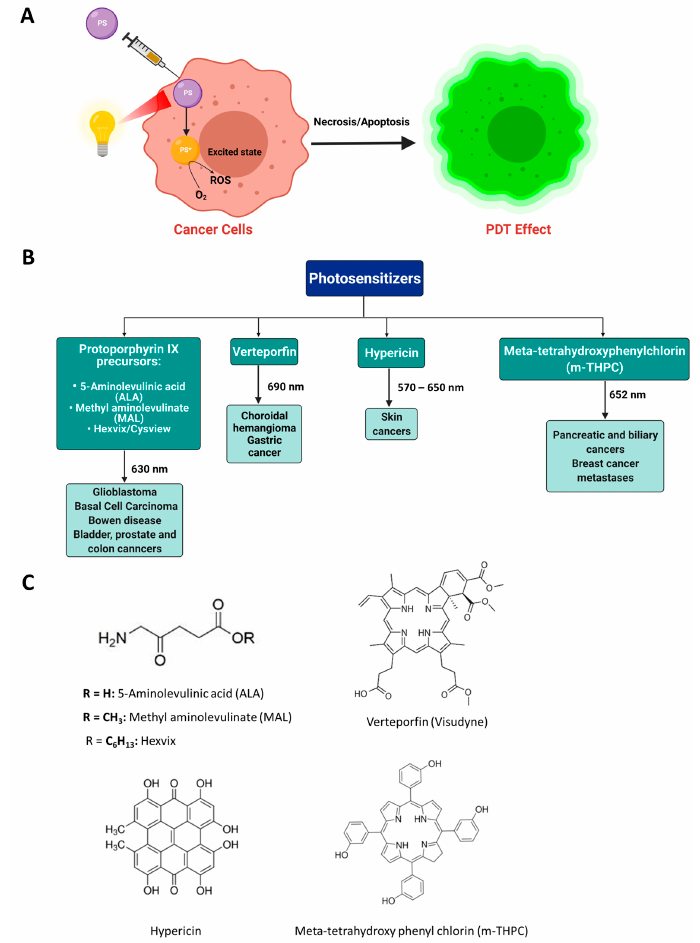
Figure 2. ( A ) General principle of photodynamic therapy; ( B ) FDA and/or EU-approved photosensi- tizers in cancer photodynamic therapy; ( C ) Chemical structures of approved photosensitizers. PS, photosensitizer; PS*, photosensitizer excited